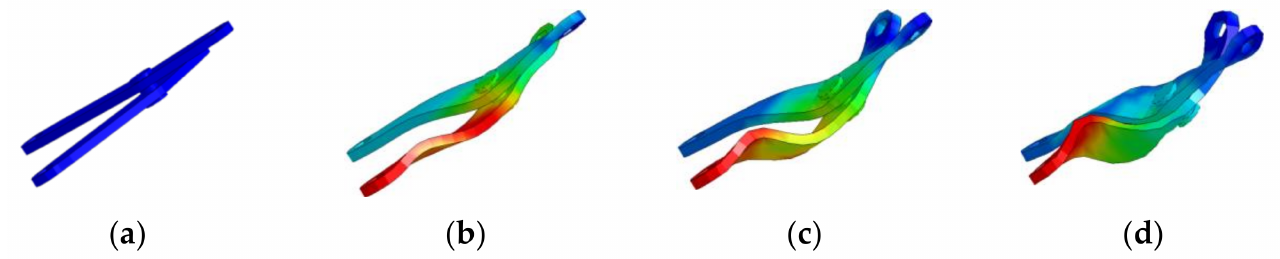
Figure 3. Deformation process of truss beam structure members under impact load: ( a ) Shape of the rod in the initial state; ( b ) Process of elastic deformation of the rod just after the impact; ( c ) Shape of the rod in contact with the rod groove in the intermediate transition process; ( d ) Final shape in the simulation analysis of the